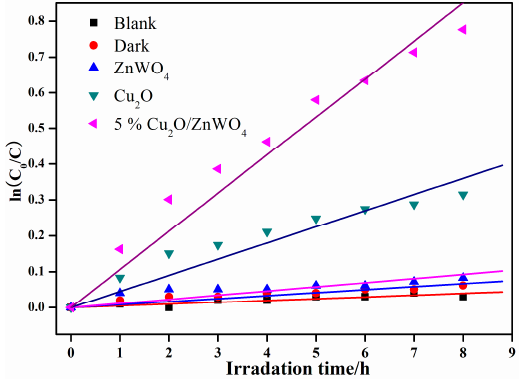
Figure 10. Linear relationship between ln( C 0 / C ) and light time of phenol degradation.